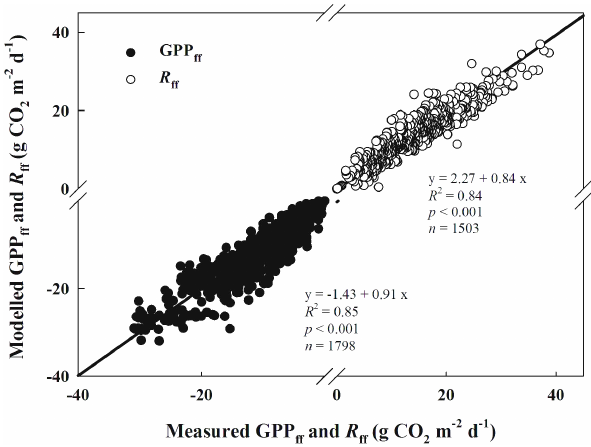
Figure 1. Goodness of fit ( R 2 ) between modelled and measured GPP ff and modelled and measured R ff values. The figure presents all data for control, experimental and drained sites for the study years (2011–2013). Lines represent the 1 : 1